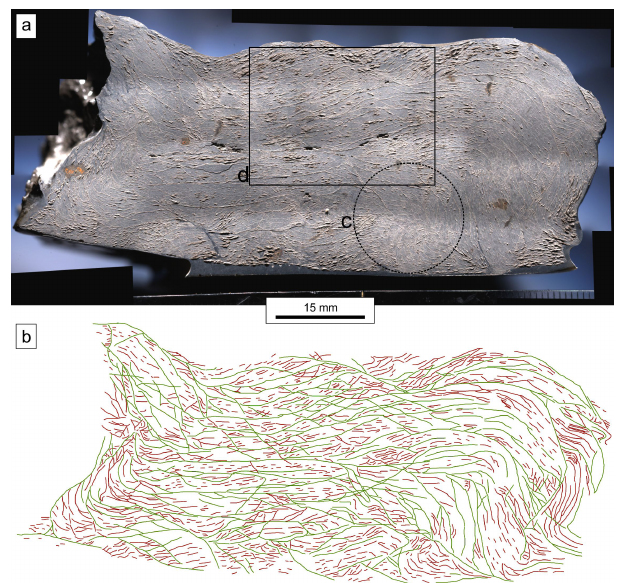
Figure 12. (a) is a shaded light RLM mosaic of a microfold in sample V12. (b) shows foliation interpretations: thin shear zones (green) encasing lensoid microlithons with sub-parallel bedding fo- liation (red). Note the overthrust-like structure in the microfold hinges on the left and right of the image. Circle (c) is a detail shown in Fig. 13. It derives from the counterpart half of the sample shown here. (d) is shown in Fig. 16.